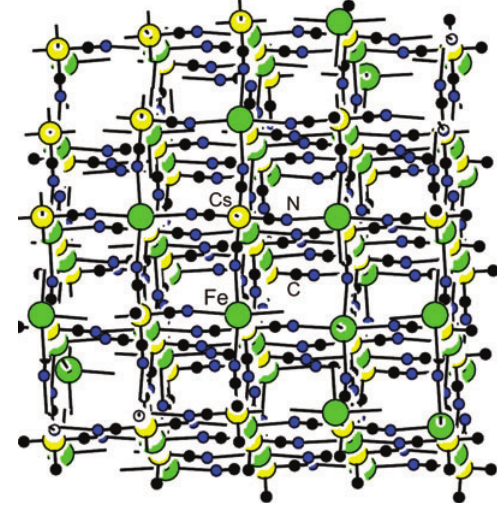
Figure 8 View of the [NMe